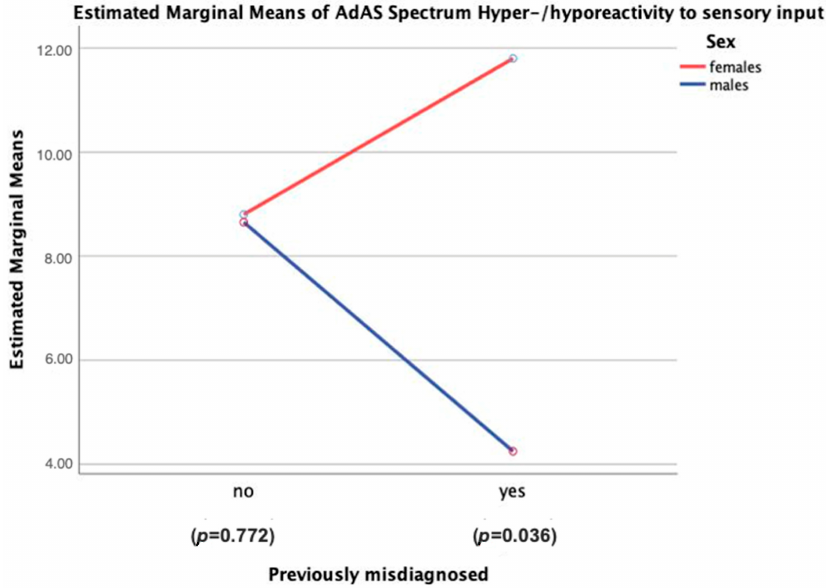
Figure 2. Gender effect on the Hyper/hyporeactivity to sensory input domain of the AdAS Spectrum in patients with or without previous